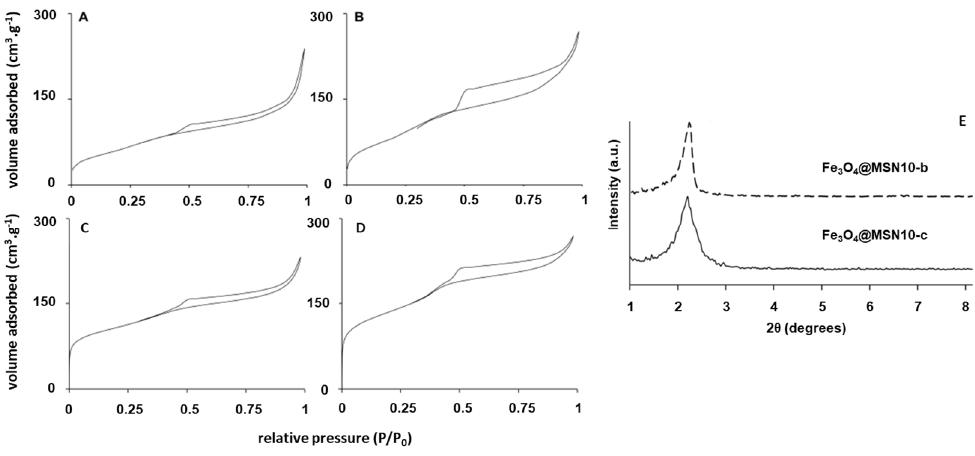
Figure 6. Nitrogen adsorption–desorption isotherms of extracted ( A , B ) and calcined ( C , D